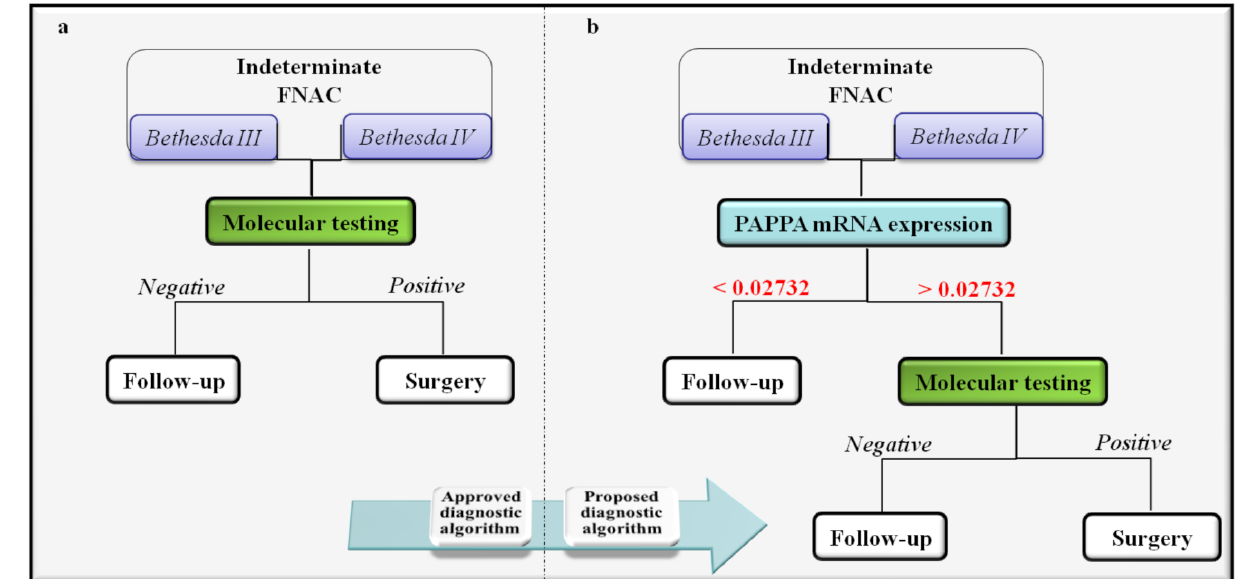
Figure 3. Classic management algorithm for indeterminate FNAC and the one proposed with the use of PAPPA mRNA expression as screening test. ( a ) Management algorithm for indeterminate thyroid nodules advocated by major societal guidelines. ( b ) Proposed management algorithm for indeterminate thyroid nodules introducing a PAPPA expression cut-off as new screening tool to select patients to be sent to molecular